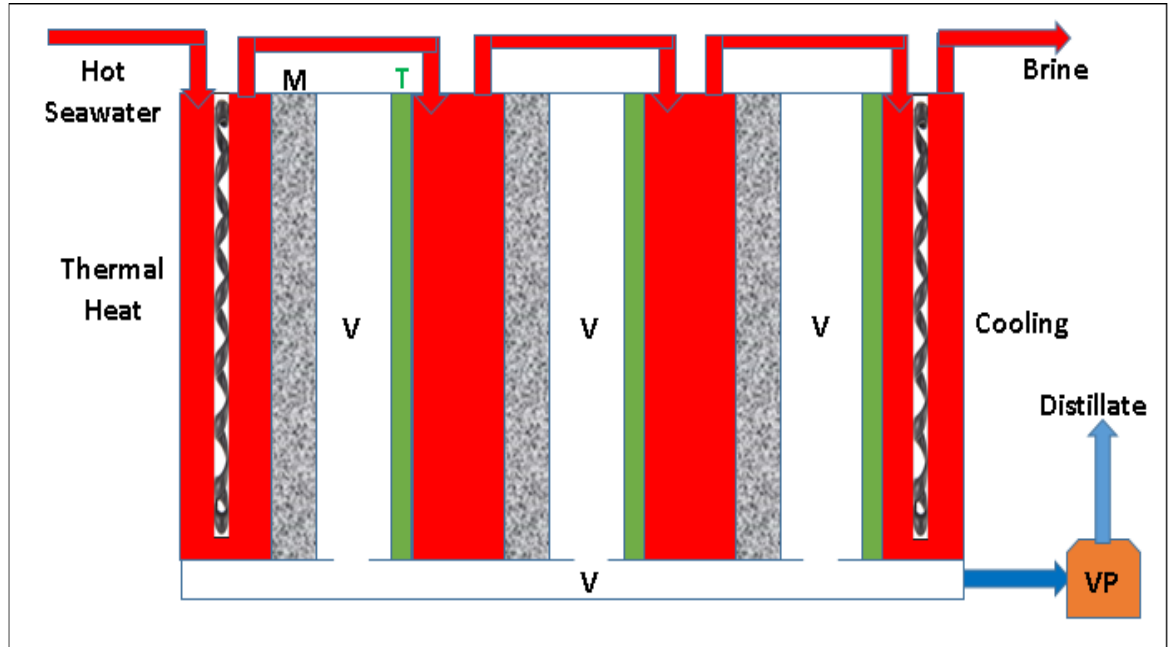
Figure 3. Schematic of the Vacuum Multi ‐ Effect Membrane Distillation.